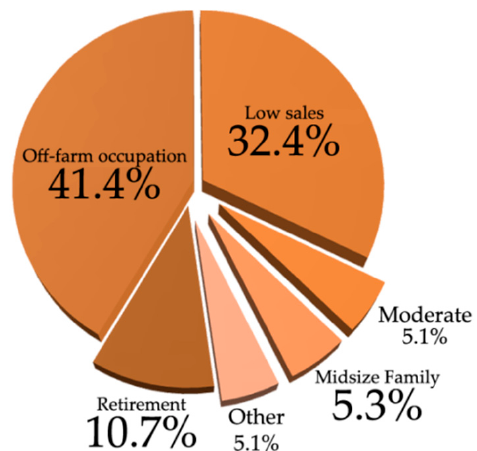
Figure 5. Farm size distribution in the US (2019).